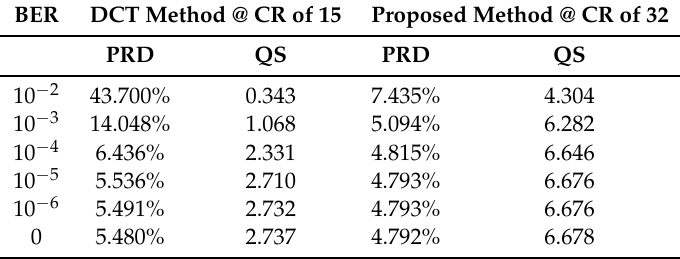
Table 7. Evaluation of the impact of communication link quality on the root-mean-square difference (PRD) and the quality score (QS).